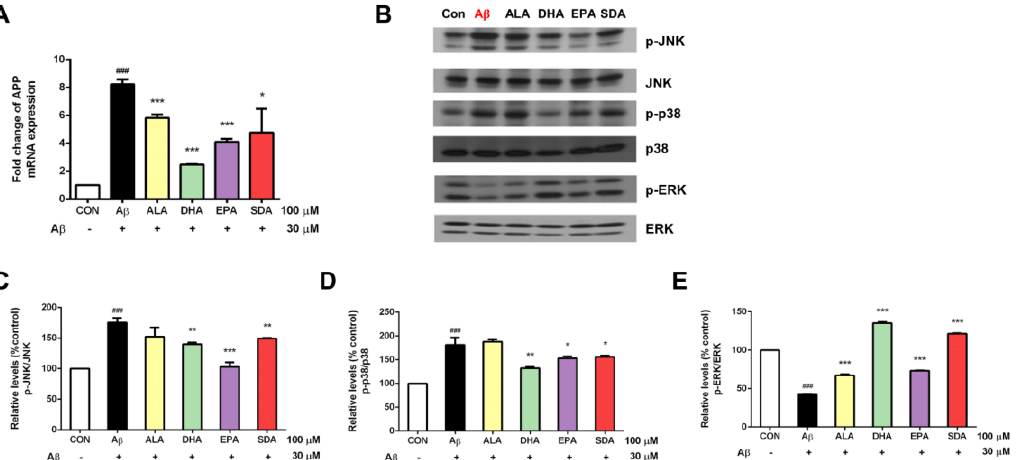
Figure 6. The anti-A β effect of SDA involves its inhibition on A β synthesis and regulation on Figure 6. The anti- Aβ effect of SDA involves its inhibition on Aβ synthesis and regulation on MAPK MAPK signaling. H19-7 cells were pretreated with ALA, DHA, EPA, SDA, or BSA–ethanol vehicle signaling. H19-7 cells were pretreated with ALA, DHA, EPA, SDA, or BSA – ethanol vehicle control control in the concentration of 100 µ M for 48 h, then 30 µ M A β 1-40 was added into the medium in the concentration of 100 μM for 48 h, then 30 μM Aβ1 -40 was added into the medium for another for another 24 h incubation. ( A ) The mRNA expression of APP. ( B ) Western blot analysis of MAPK signaling activation. The ratios of ( C ) p-JNK to JNK, ( D ) p-p38 to p38 and ( E ) p-ERK to ERK were determined. Values were obtained from three independent experiments and were expressed as the means ± SEM. ### p < 0.001, different from BSA–ethanol vehicle-treated control cells; * p < 0.05, ** p < 0.01, *** p < 0.001, different from A β -treated